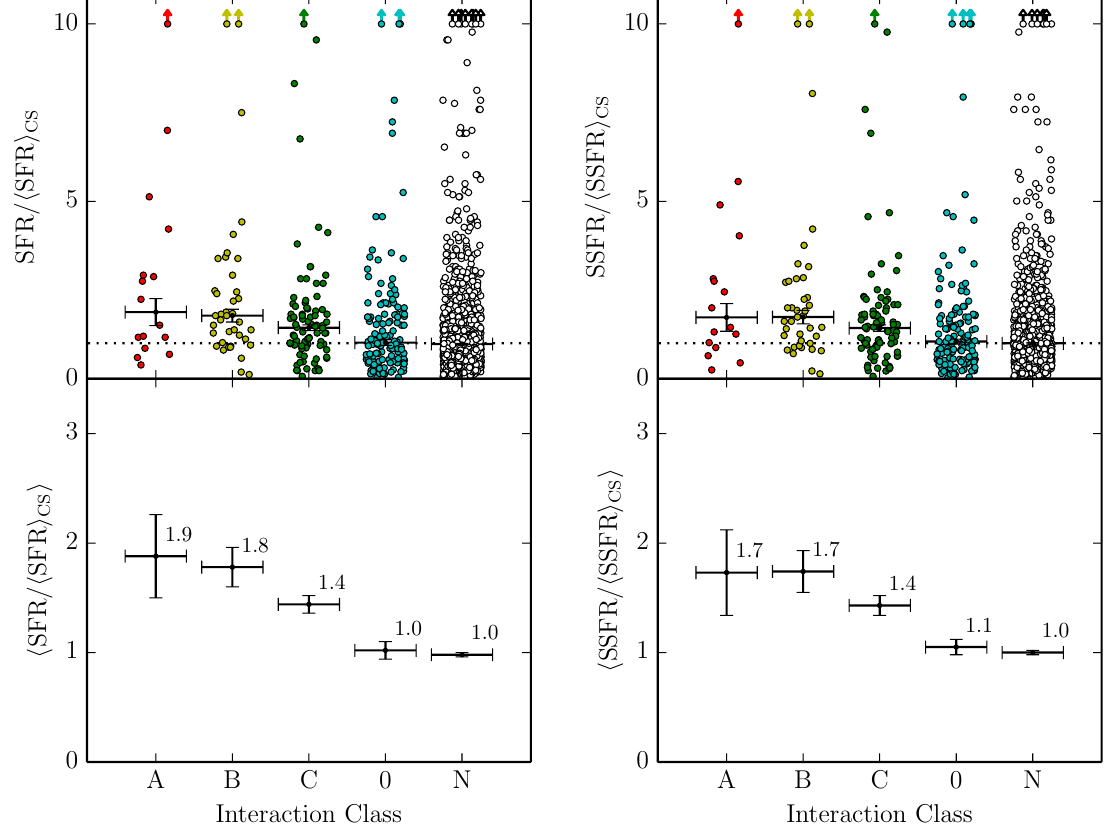
Figure 3. The SFR ( left panels) and SSFR ( right panels) enhancement, defined as the (S)SFR of a galaxy normalised by the median (S)SFR for its control population, separated by interaction class (where A is the most extreme class, of mergers, and N contains non-interacting galaxies). Values larger than 10 are indicated by lower limits. The median values per class are indicated in both top and lower panels, but are amplified in the lower panels where the values are indicated next to the data points. Error bars indicate 1 σ uncertainties. From